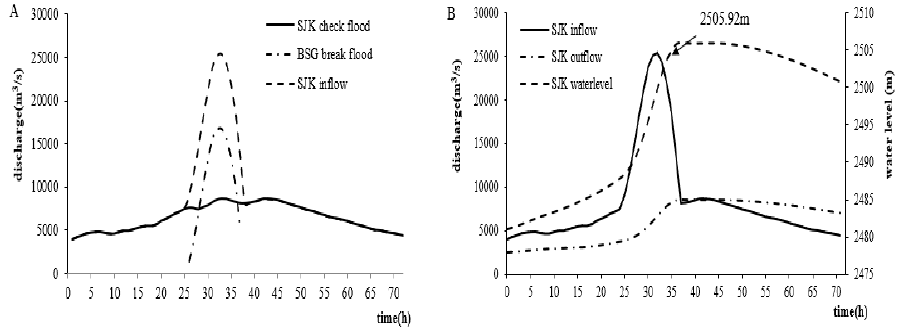
Figure 18. ( A ) The BSG break flood encounters SJK check flood; ( B ) the regulated flood progress of SJK.